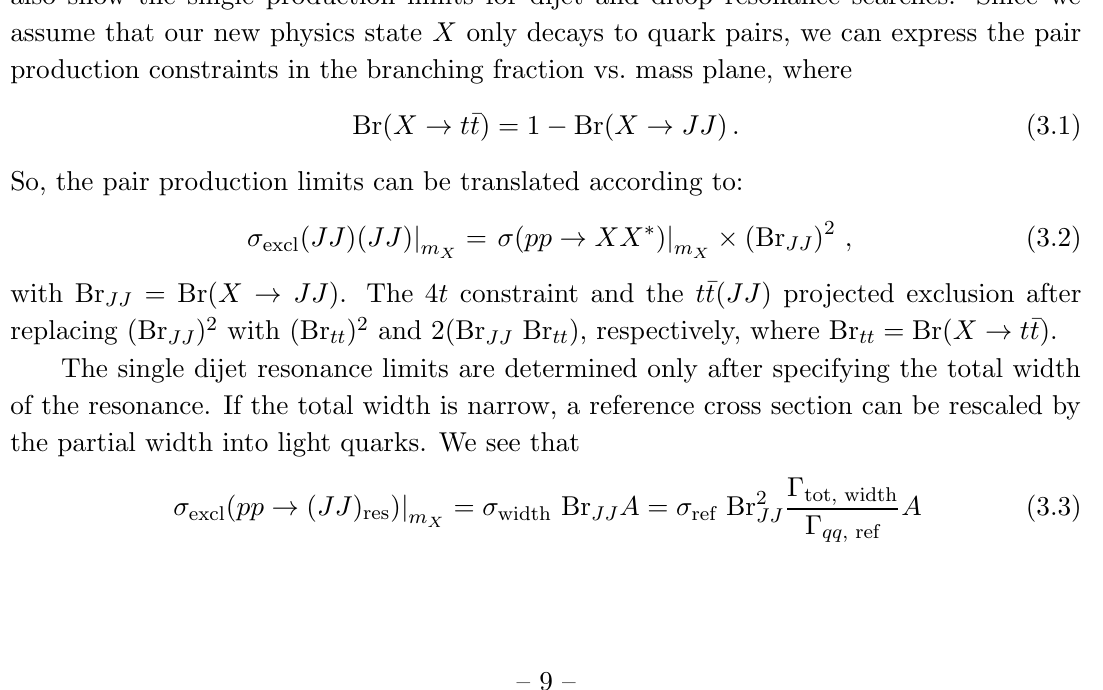
Table 2 . Cut (cid:13)ow for a di(cid:11)erent resonance masses m X and dominant background t (cid:22) t +jets for the fully leptonic search. All branching ratios are applied to signal and background when quoting cross sections. We normalize the signal assuming Br( X ! t (cid:22) t ) = Br( X ! JJ ) = 50%. the same relative signal to background ratios as the semi-leptonic analysis, but the absolute rate is only an (cid:25) 5% additional contribution compared to the semi-leptonic